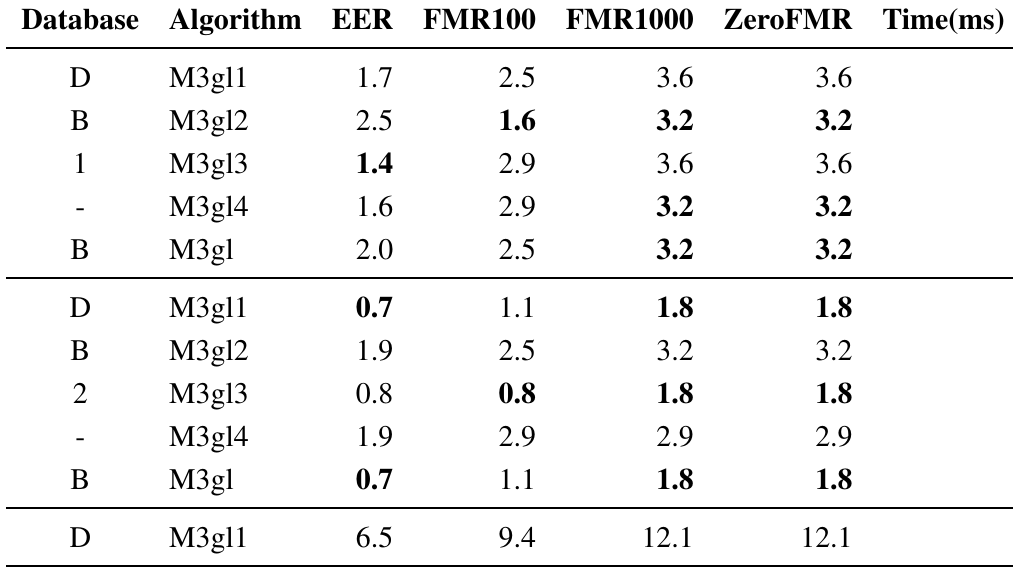
Experimental results on databases DB1 B, DB2 B, DB3 B and DB4 B of